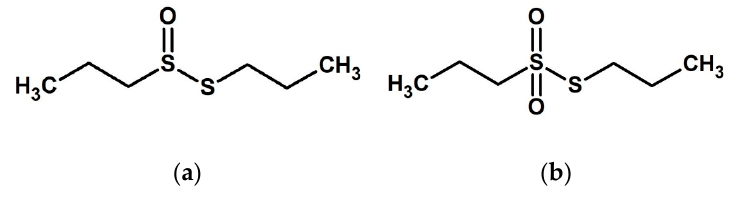
Figure 1. Chemical structure of PTS ( a ) and PTSO ( b ).